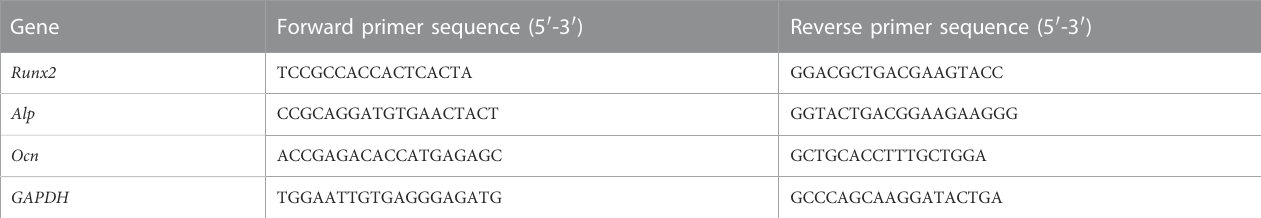
TABLE 2 Primer sequences used for qRT-PCR gene expression analysis. Gene Forward primer sequence (5 ′ -3 ′